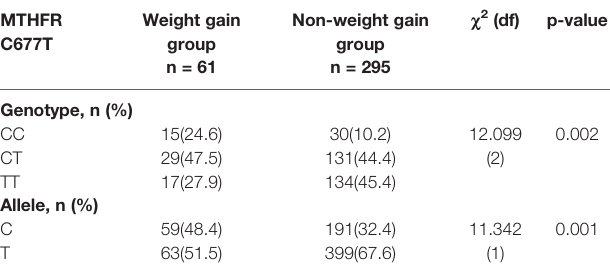
TABLE 2 | Comparison of MTHFR C677T genotype and allele frequency between groups with and without signi fi cant weight gain (%). MTHFR Weight gain C677T